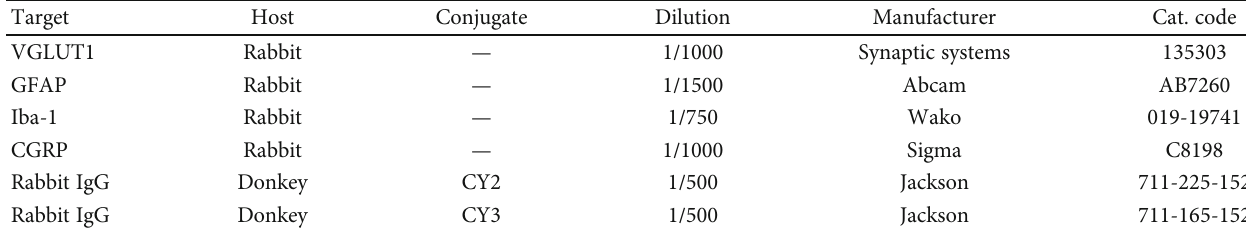
Table 2: Antibodies used in the immuno fl uorescence